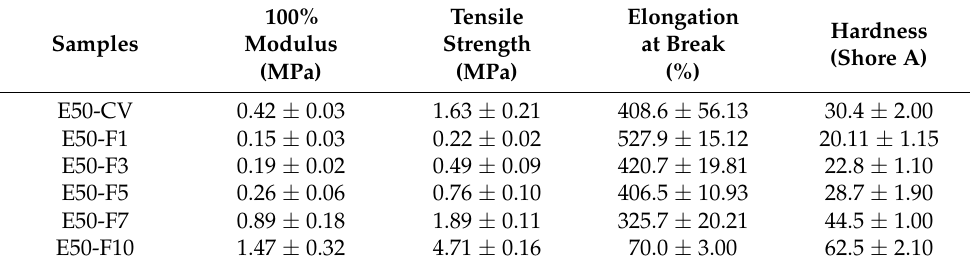
Figure 6. Stress–strain curves of ENR-50 compounded with various concentrations of FeCl 3 at 1, 3, 5, 7 and 10 mmol, and the conventional sulfur vulcanization (i.e., E50-CV). Table 4. Mechanical properties in terms of 100% modulus, tensile strength, elongation at break and hardness (Shore A) of ENR-50 compounded with various concentrations of FeCl 3 at 1, 3, 5, 7 and 10 mmol and the conventional sulfur vulcanization (i.e.,